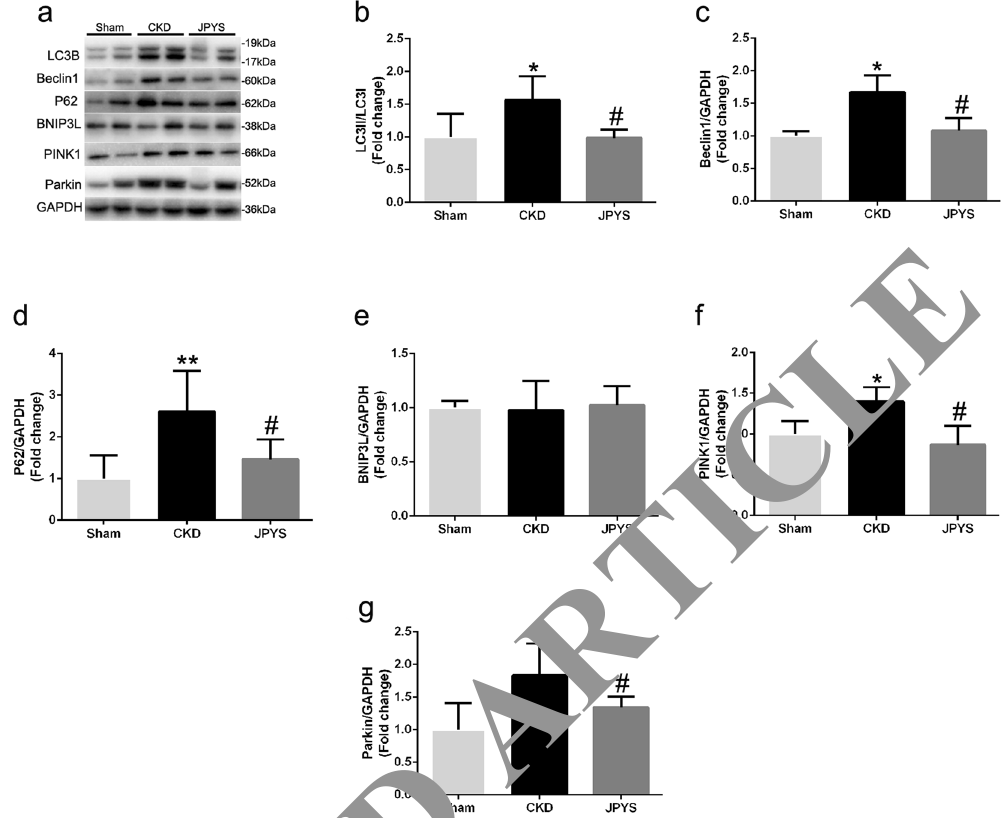
Figure 6. Effect of JPYS decoction on skeletal muscle autophagy/mitophagy pathway in 5/6 nephrectomised rats. ( a ) Representative Western blot images of LC3B, Beclin1, P62, BNIP3L, PINK1 and Parkin protein expression. Quantification of ( b ) LC3II/LC3I ration, ( c ) Beclin1, ( d ) P62, ( e ) BNIP3L, ( f ) PINK1 and ( g ) Parkin protein levels. GAPDH was used as loading control. Data are expressed as Fold change vs. Sham and reported as means ± SD, n = 6 per group, * P < 0.05, ** P < 0.05 between Sham and CKD groups. # P < 0.05 between CKD and JPYS